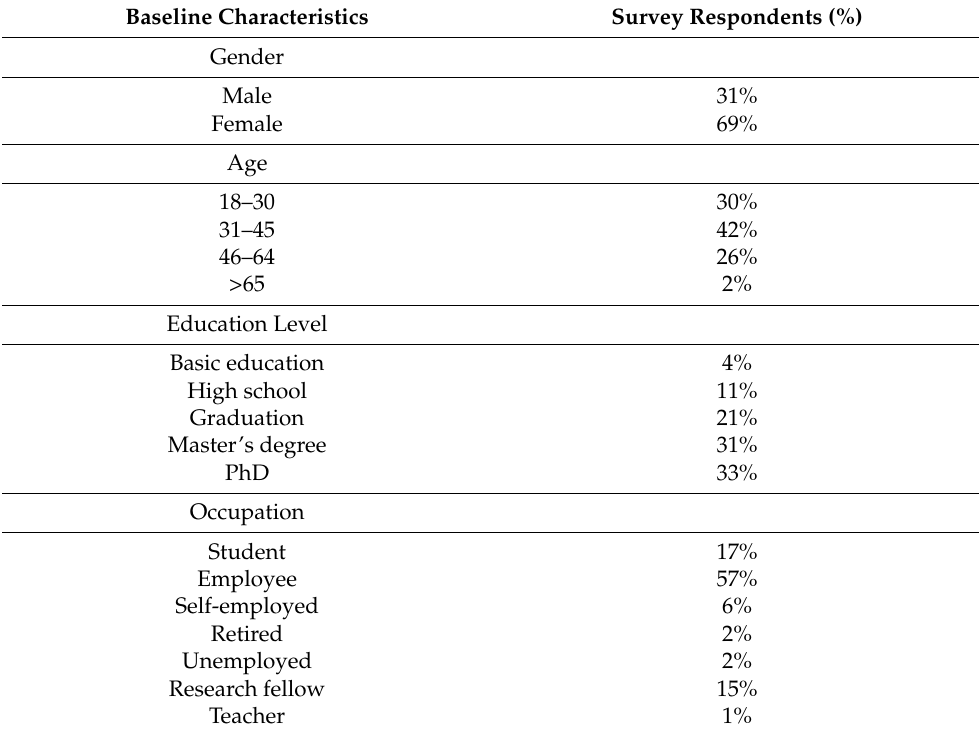
Table 1. Results of market survey concerning consumers’ gender, age, education level, and occupation ( n = 155).